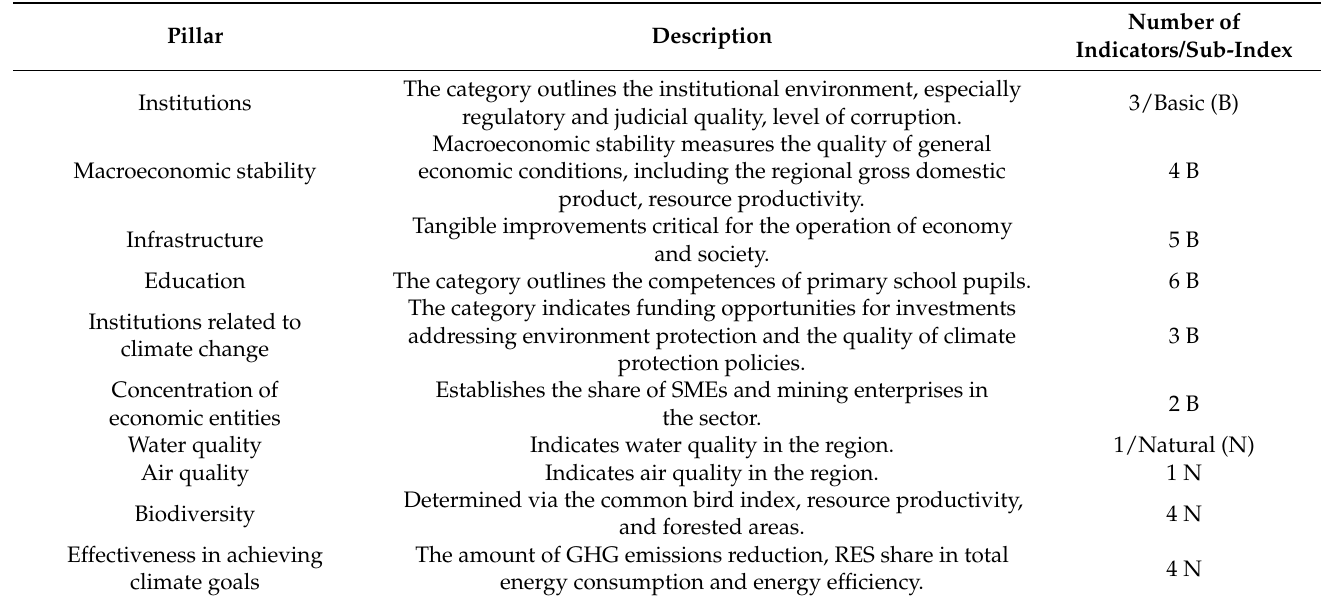
Table 1. List of pillars with their